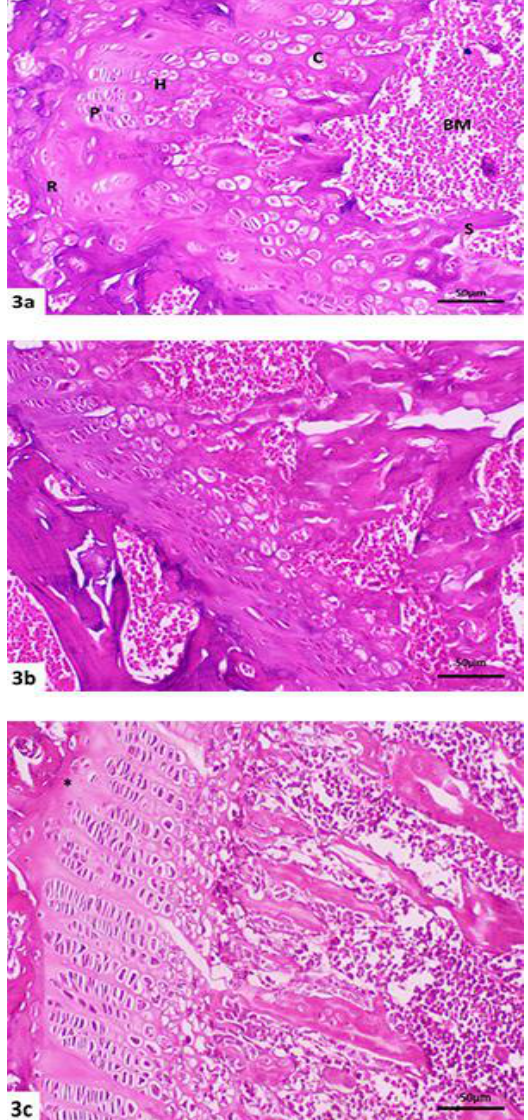
Figures. (3a-c) : Photomicrographs of H & E stained sections in epiphyseal growth plate of tibia from (a): control group showing well organized epiphyseal cartilage forming the different zones: reserve zone (R), proliferative zone (P) (columns of proliferating chondrocytes). Hypertrophy zone (H) (enlarged chondrocytes), calcification zone (C) (with empty lacunae and surrounding basophilia of calcified matrix. Primary spongiosa (S) are formed of trabecular spicules and intervening bone marrow (BM) cavities. (b): PTU group showing disorganized epiphyseal cartilage, disruption in chondrocyte columnar arrangement, and reduction in chondrocyte number in proliferative zone. Trabeculae of primary spongiosa are separated with multiple bone marrow cavities. Note the reduced thickness of growth plate. (c): PTU+Ash group showing well organized epiphyseal cartilage plate and preservation of resting zone and increased number of stacked chondrocytes. Some areas of cartilage plate are devoid of chondrocytes (*). (3a-c x200- scale bar 50µm)